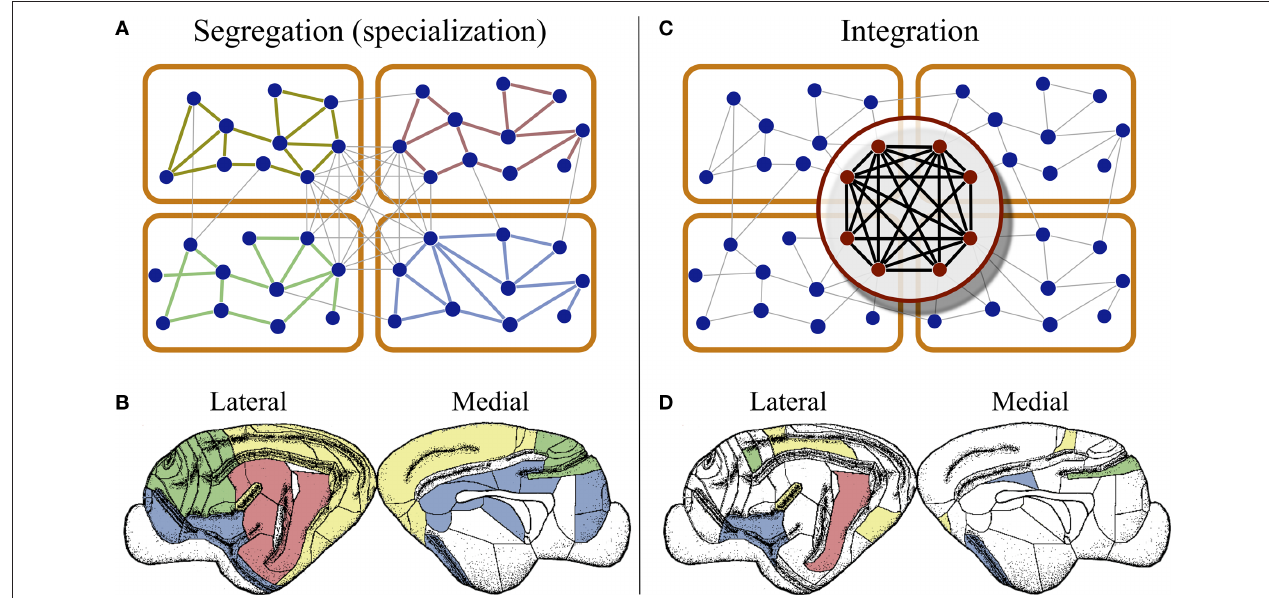
visual (yellow), auditory (red), somatosensory-motor (green), and frontolimbic (blue) areas in the cortex of cats. (C) Cortical hubs form a central module at the top of the cortical hierarchy, which is capable of integrating multisensory information as the coordinated activity of the hubs. (D) This module can only be detected by connectivity analysis because cortical hubs are dispersed throughout the cortical